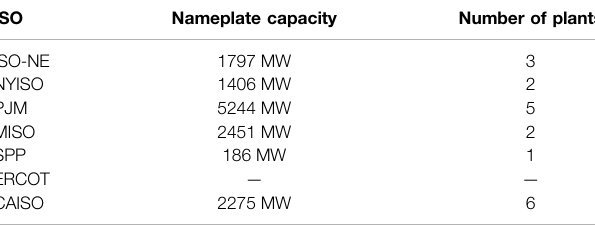
TABLE 2 | Pumped storage hydro capacity (MW) operational by ISO,